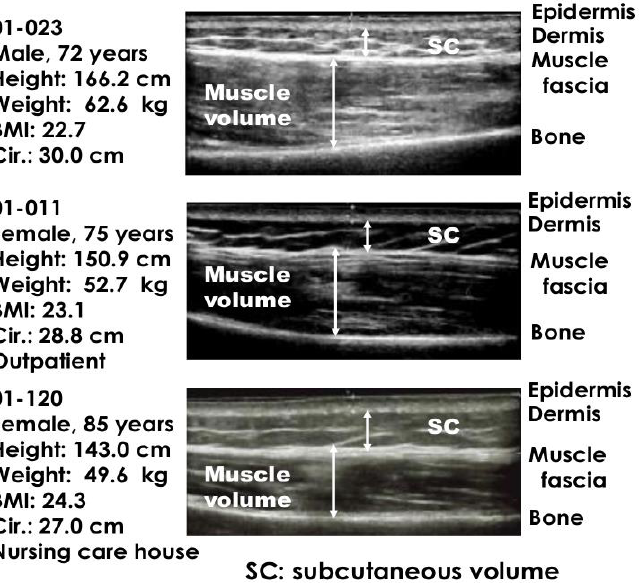
Figure 1. Typical echography in different age groups in the center of the deltoid muscle area.